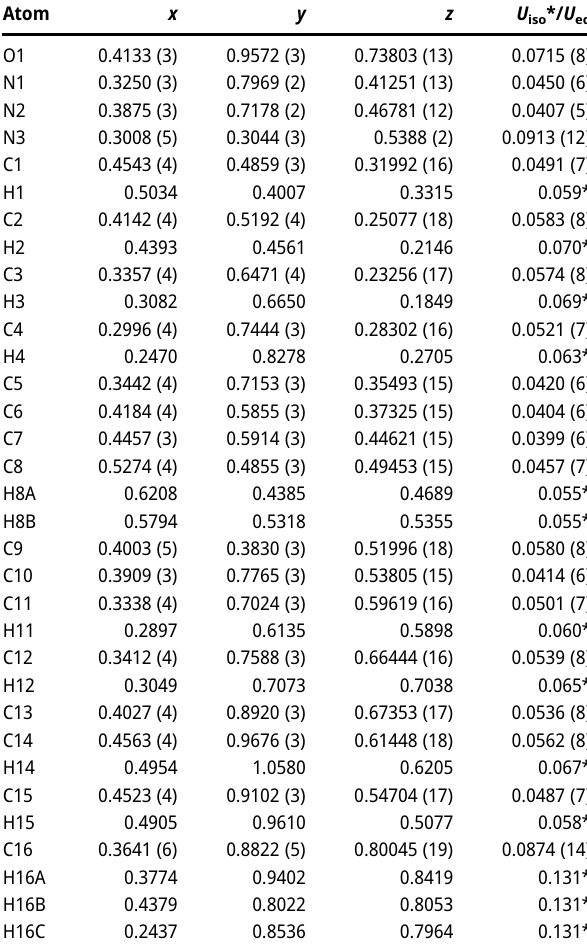
Table  : Fractional atomic coordinates and isotropic or equivalent isotropic displacement parameters (Å 